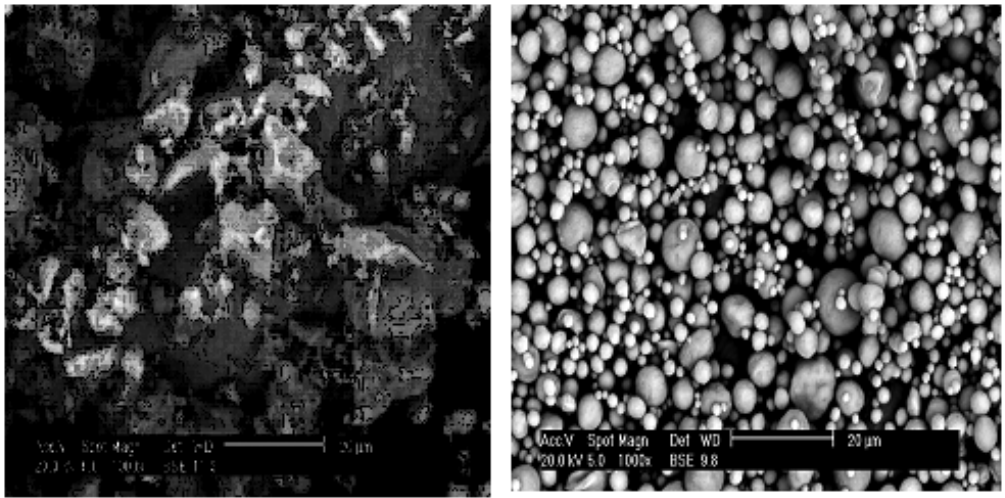
Fig. 3 – Scanning electronic microscopy micrographs of: (a) iron oxide magnetic particles before spray-drying and (b) iron oxide magnetic particles after spray-drying.